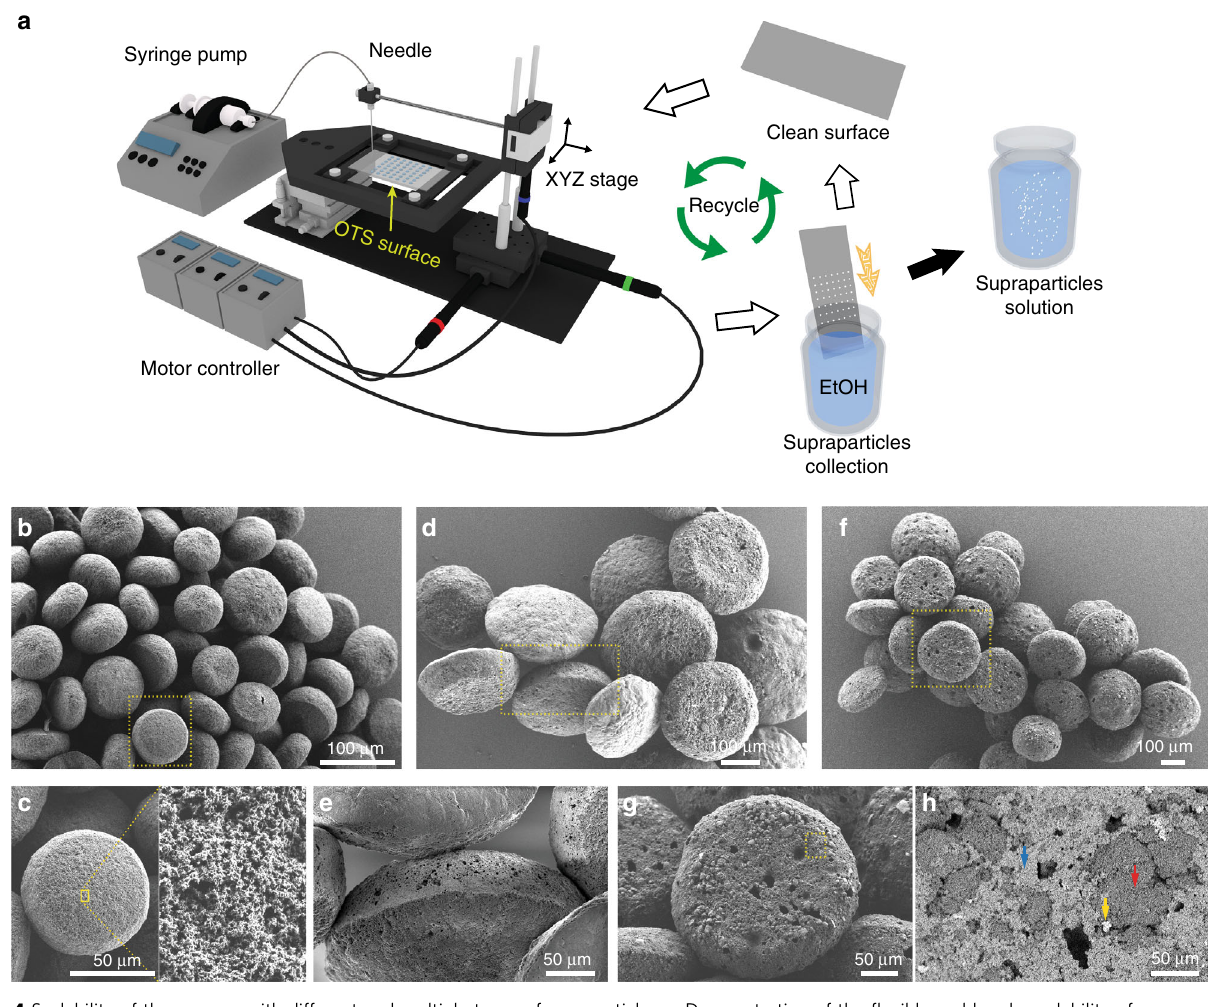
Table 1 Composition list of the colloidal solutions for Fig. 4